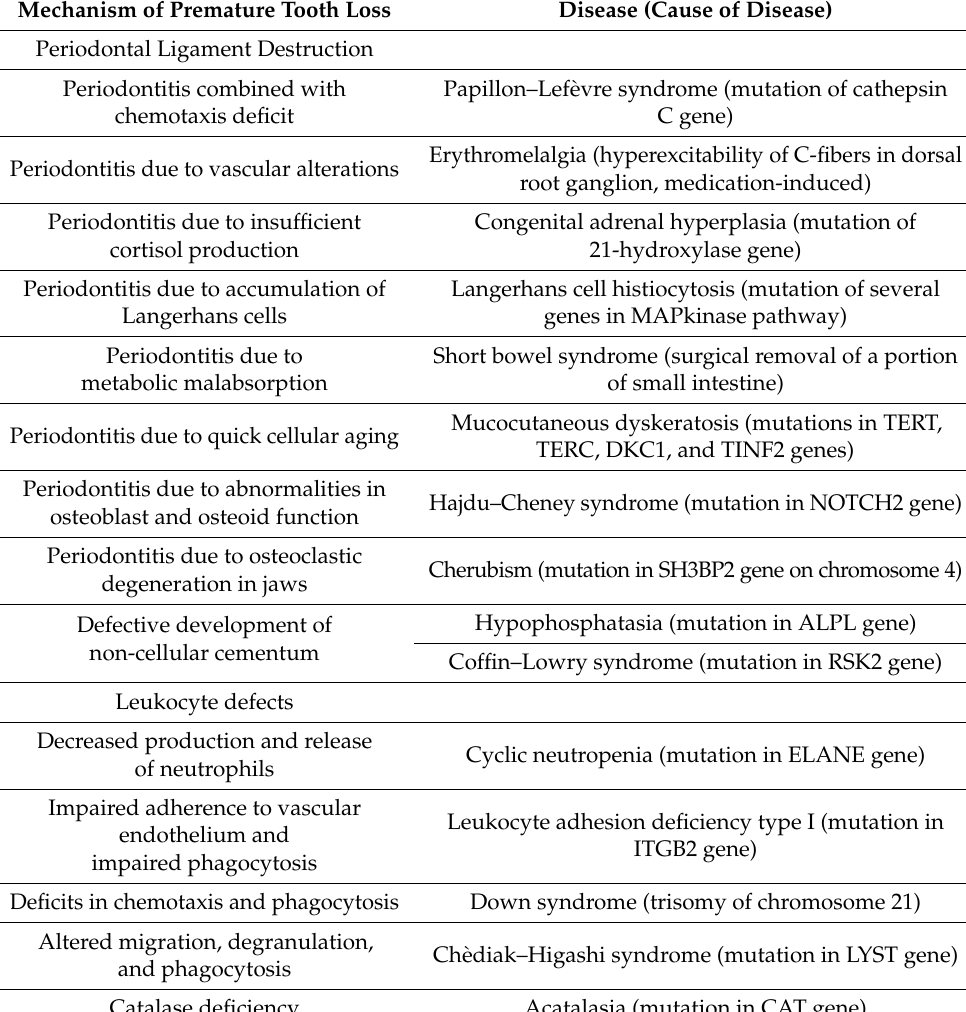
Table 1. Mechanisms of premature deciduous tooth loss due to systemic